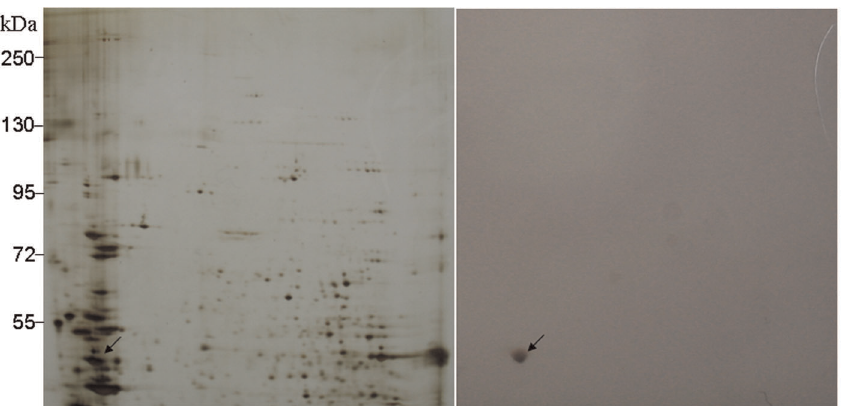
Figure 5. Blot detection of actin in Chilosuppressalis midgut. Proteins were separated by 2D-gel electrophoresis. Arrows denote positions of the anti-actin antibody binding protein. The filters were first probed with mouse anti-beta-actin monoclonal antibody (Sigma) and then visualized with goat anti-mouse IgG conjugated with alkaline phosphatase (Sigma) and the BCIP/NBT system (Sigma). Positions of molecular size markers (kDa) are indicated on the side of